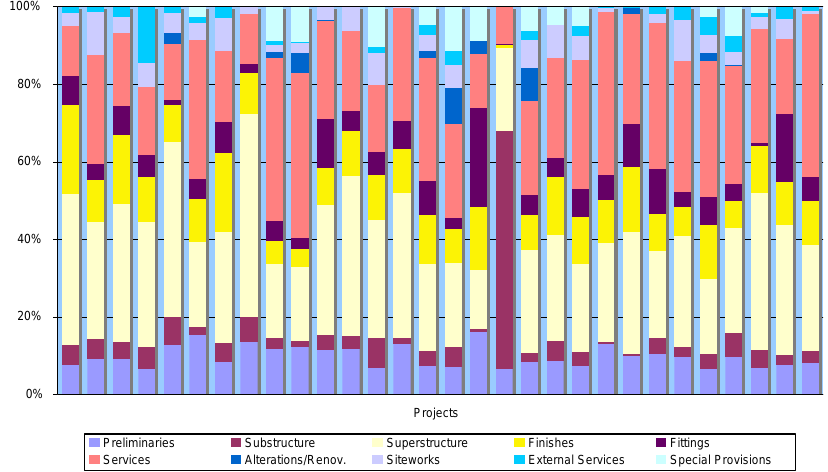
Figure 8: Distribution of Capital Cost by Project Similarly, Figure 9 looks at operating cost excluding the cost of energy. The dominance of Preliminaries is a striking change to Figure 4 and